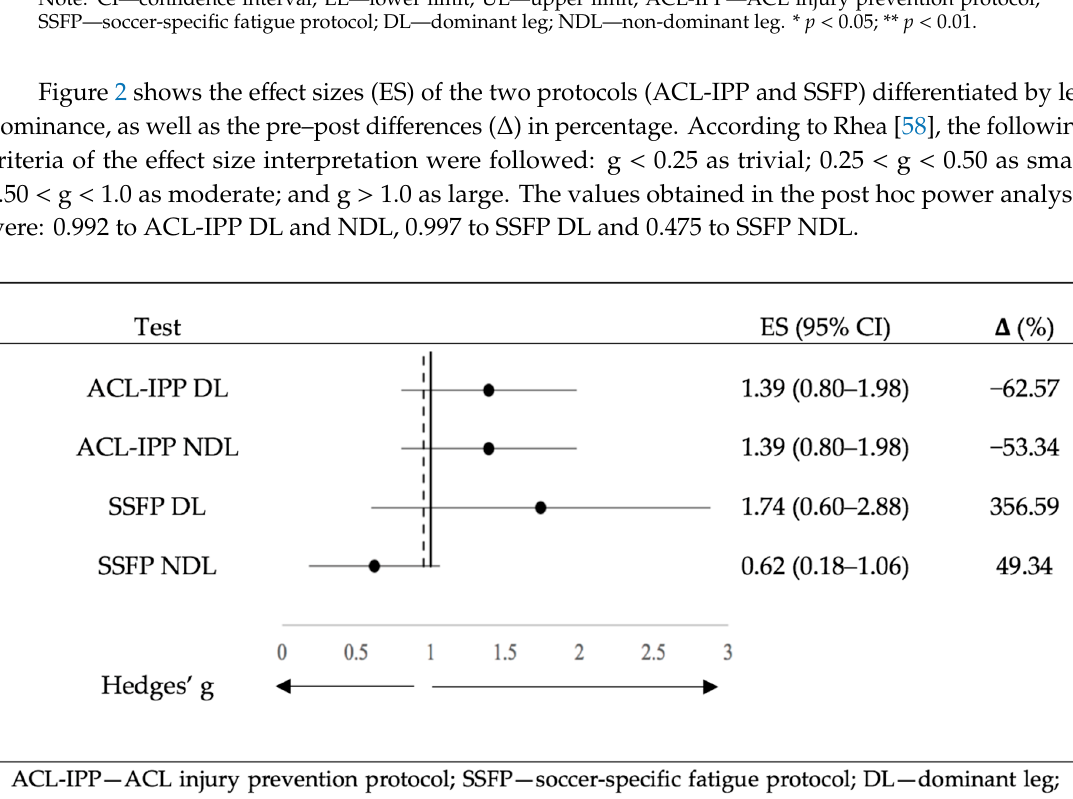
Table 1. Average pre–post intervention data in the protocols differentiated by leg dominance.